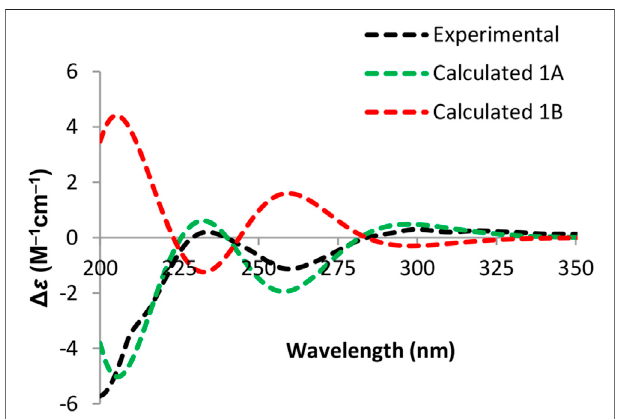
FIGURE 4 | Experimental and calculated ECD spectra of part A .